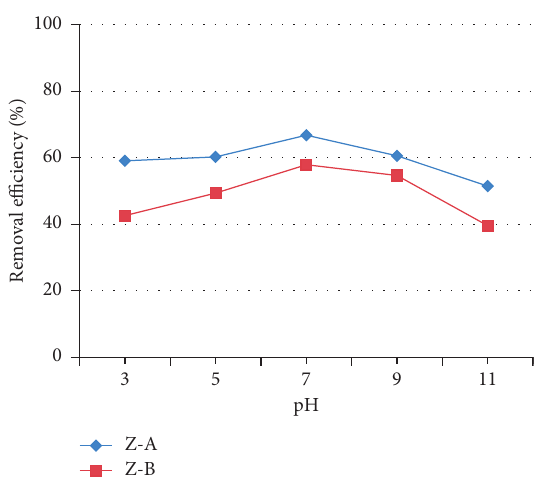
Figure 7: Effect of pH on removal efficiency of Z-A and Z-B.